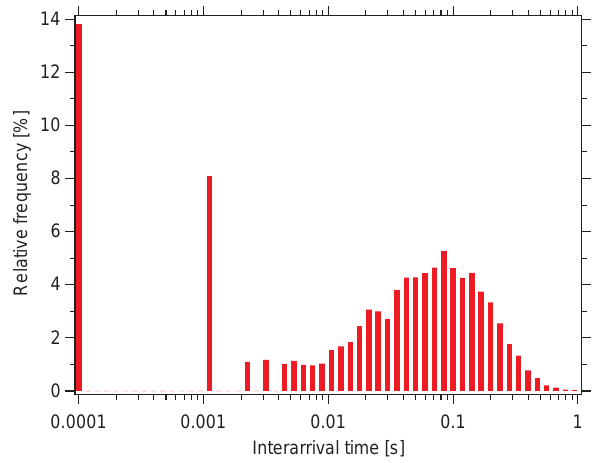
Figure 6. Inter-arrival time histogram of the CARIBIC OPSS for 500nm PSL particles and a number concentration of about 60 par- ticlescm − 3 .